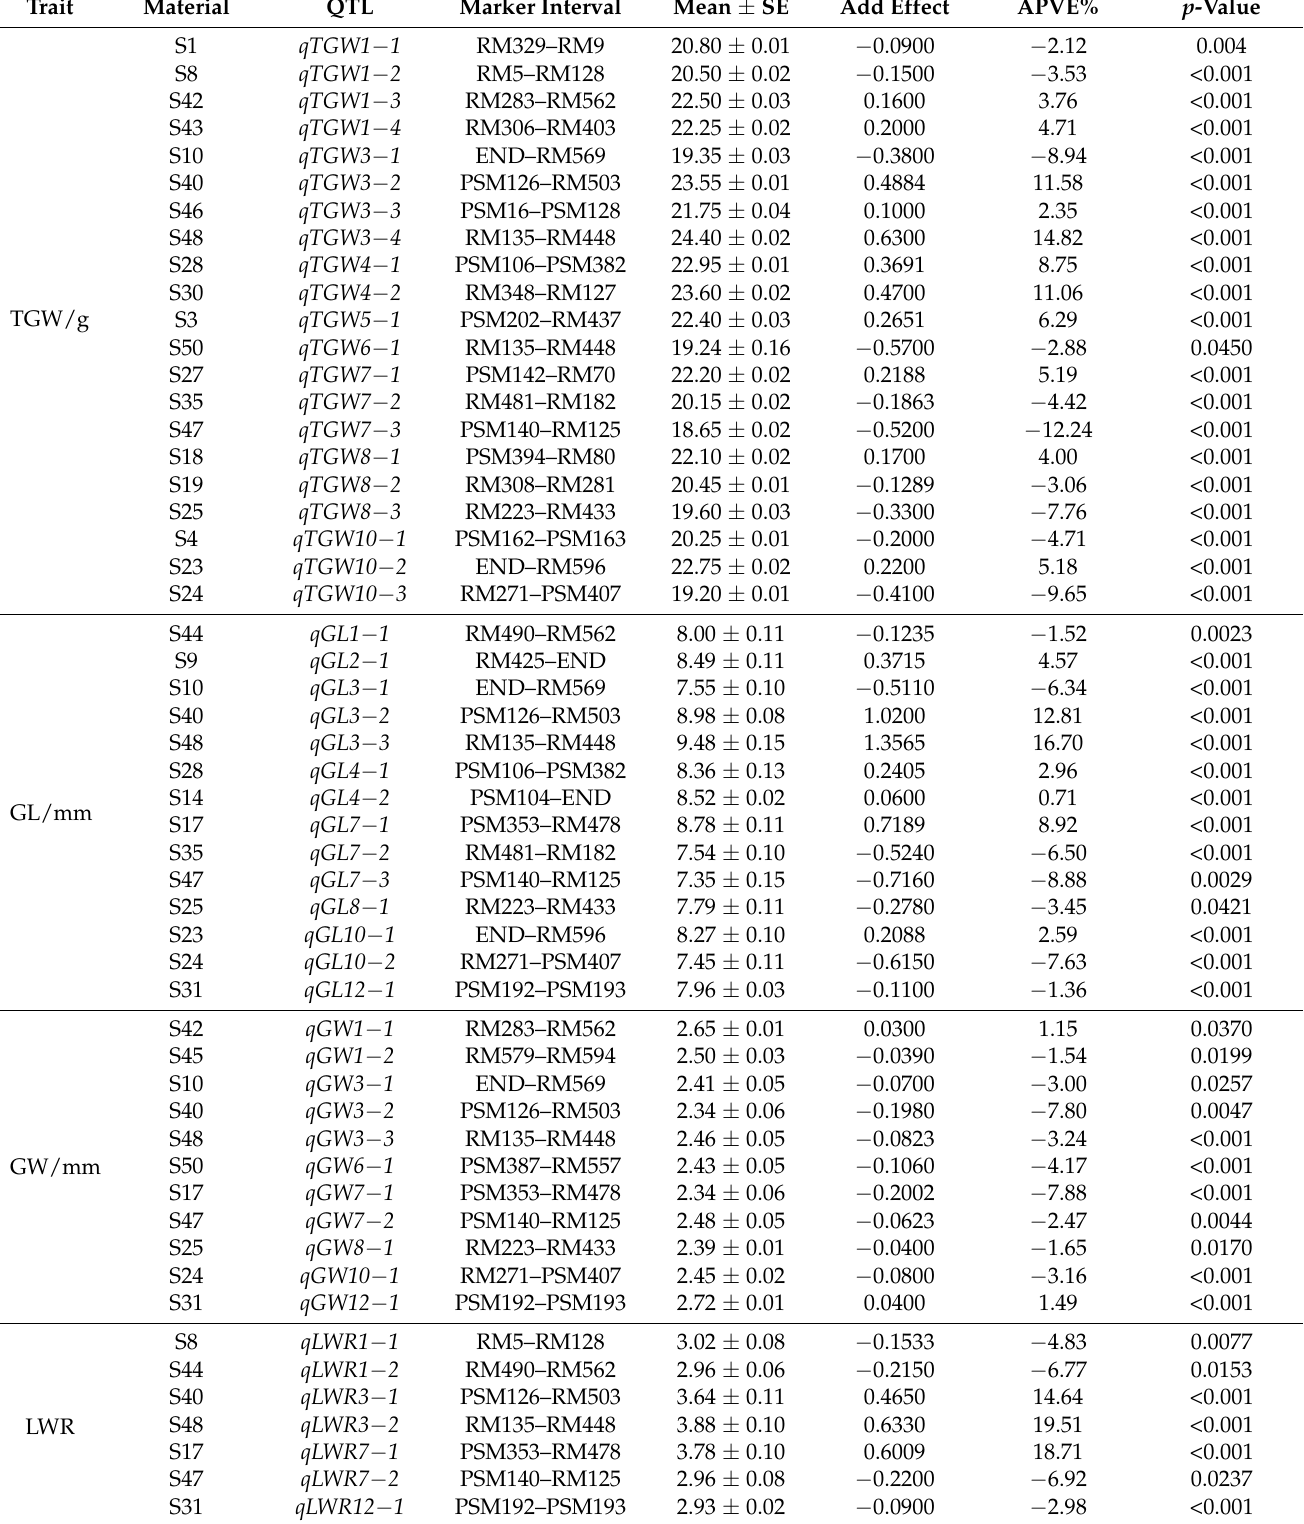
Table 1. QTLs Identified for Grain Shape Using SSSLs (n =